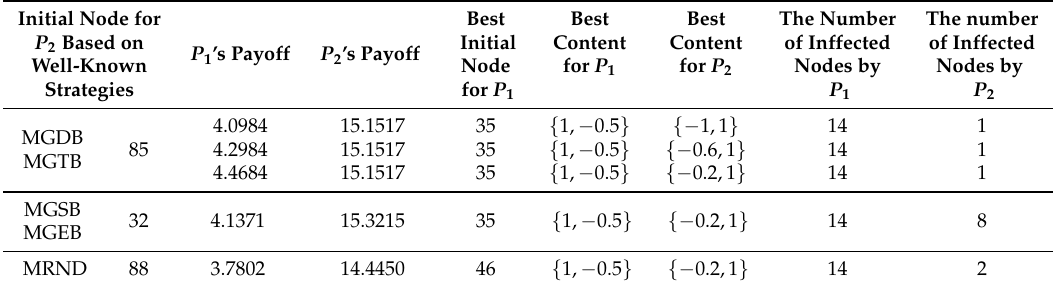
Table 5. Nash equilibrium when player 2 performs based on some well-known